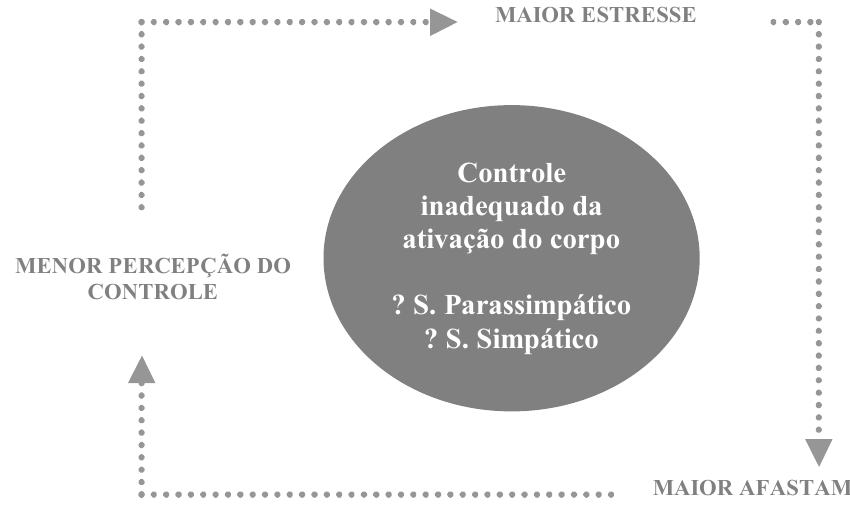
Figura 1. Dinâmica social da hipertensão